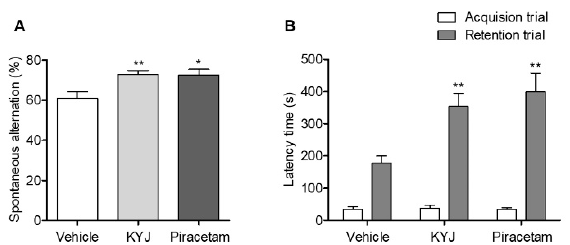
Figure 3. KYJ enhanced memory functions in mice. Y-maze test and passive avoidance test were performed 13 to 15 days after the administration of piracetam or KYJ, respectively. ( A ) The spontaneous alternations (%) in the Y-maze test and ( B ) the latency time (s) to enter the dark compartment during the acquisition trial (white) and 24 h later during the retention trial (gray) in passive avoidance test. * p < 0.05 and ** p < 0.01 vs. the vehicle-treated group.